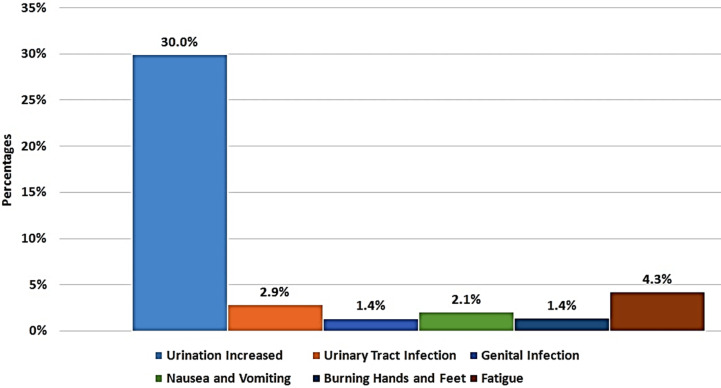
Patients Reported Adverse Events with SGLT2 Inhibitors(Empagliflozin &Dapagliflozin) During Follow Up Visit (n=140).